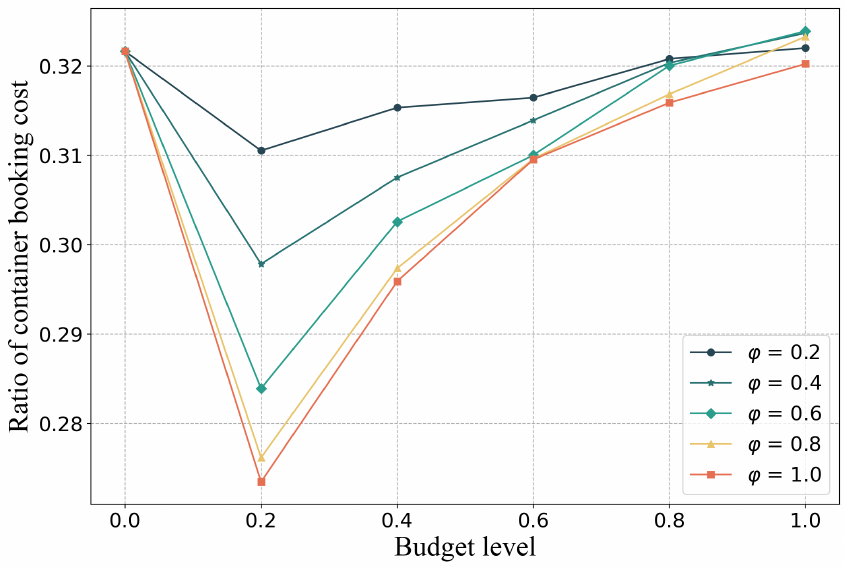
Figure 3. Impact of the uncertain budget level on ratio of container booking cost. Table 4. Detailed comparison of costs under different budget levels and demand deviation levels.